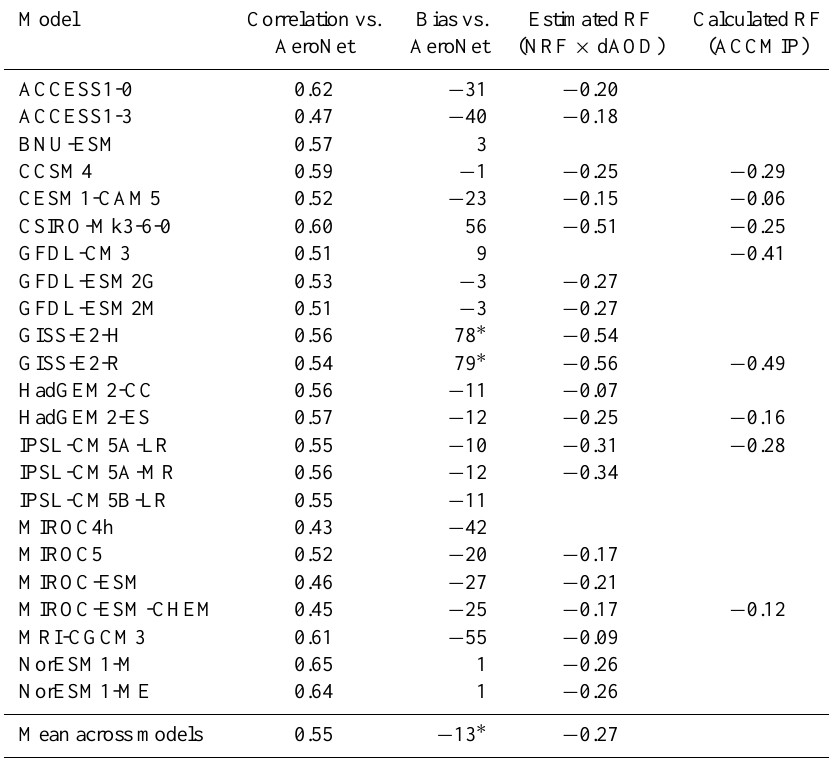
Table G1. Aerosol AOD and estimated RF from CMIP5 models. Model Correlation vs. Bias vs. Estimated